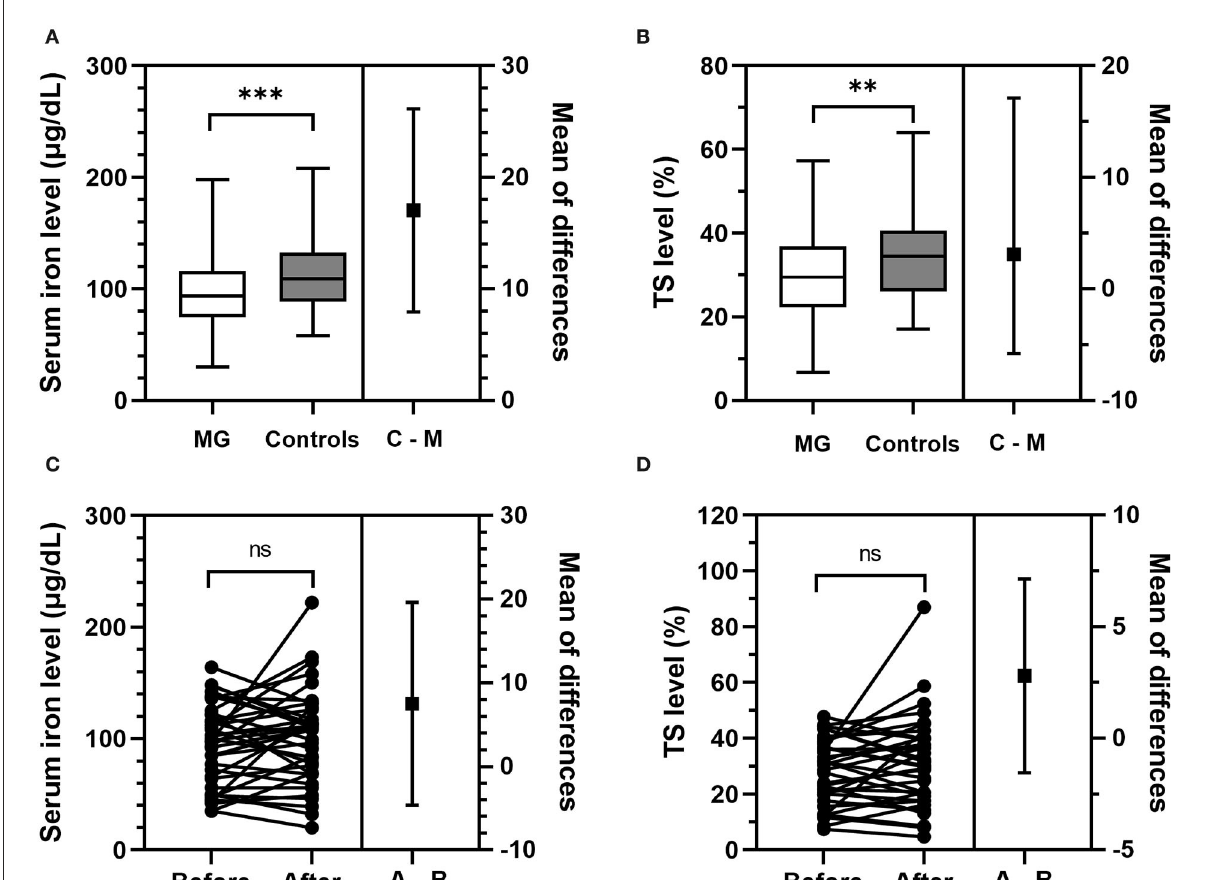
FIGURE2 Comparison of SI and TS levels between immunotherapy-naive patients with MG and controls, and between patients with MG before and after initiation of immunotherapy. (A,B) Compared with matched healthy controls, immunotherapy-naive patients with MG had significantly lower levels of SI ( p < 0.001) and TS ( p = 0.002). “C–M” stands for “controls minus MG,” which is the difference in the SI level or TS level between patients with MG and controls. (C,D) The same group of patients with MG had comparable levels of SI ( p = 0.217) and TS ( p = 0.420) before and after starting immunotherapy. “A–B” stands for “after minus Before,” which is the difference in the SI level or TS level between patients with MG before and after receiving immunotherapy. ** p < 0.01, *** p < 0.001. MG, myasthenia gravis; ns, not significant ( p ≥ 0.05); SI, serum iron; TS, transferrin